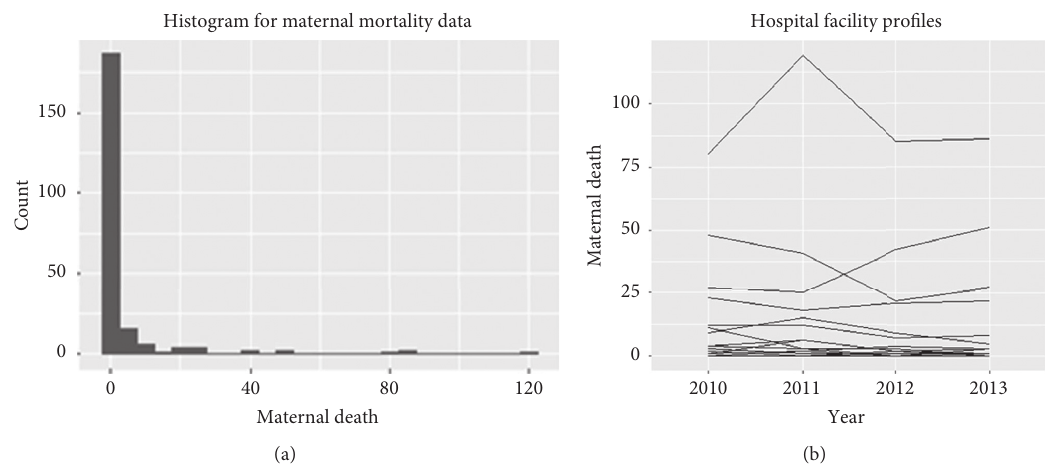
Figure 1: Maternal mortality data. Histogram and hospital facility